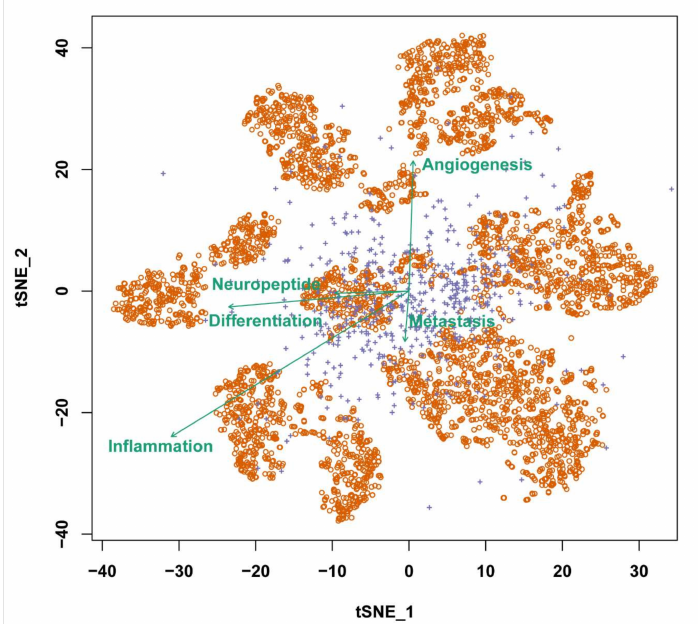
Figure 5. The t-SNE biplot demonstrates the connection between intratumor heterogeneity and cell status in 4825 oligodendroglioma cells. The orange circles represent cells, whereas the purple “+” represents the genes with the highest percentage of variants. Green vectors represented the five cell